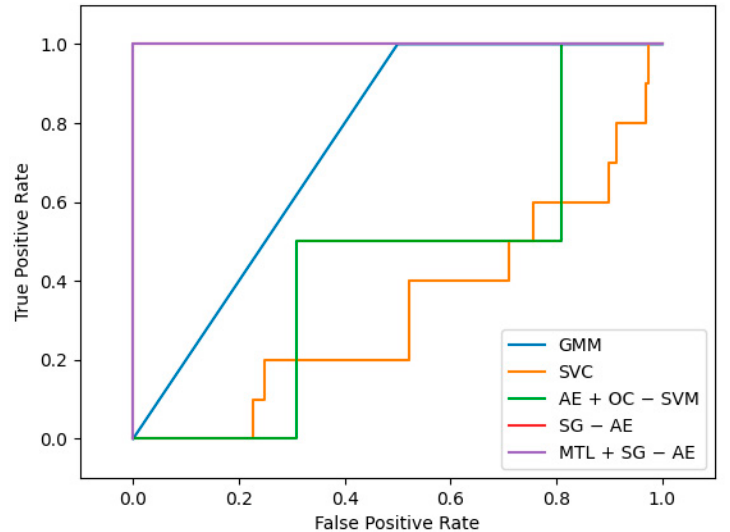
Figure 13. The best ROC curves of the five algorithms, in which the curve of SG − AE coincides with the curve of MTL + SG − AE.